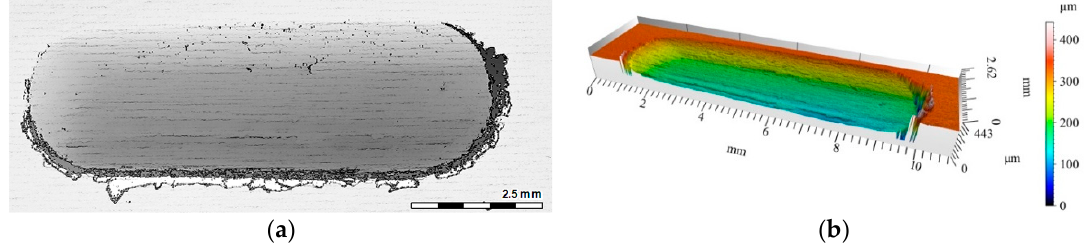
Figure 10. View of wear track in the S5 single composite layer (marked with a black line in Figure 8a) after dry sliding: ( a ) digital image; ( b ) cross-section through 3D view.